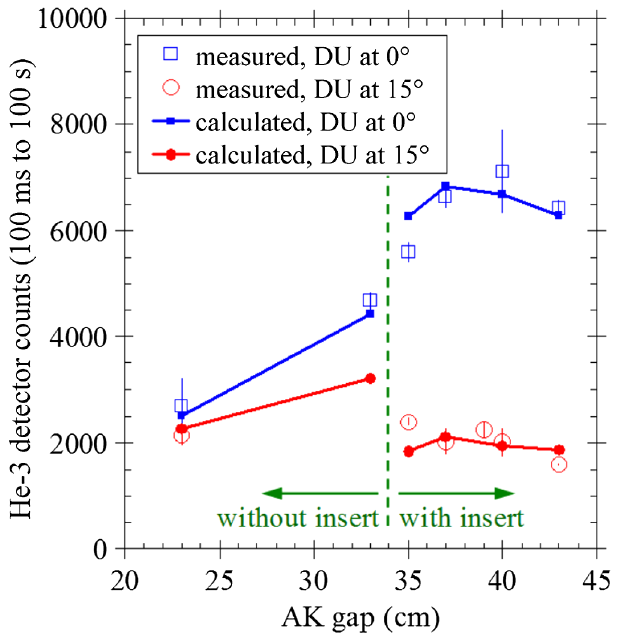
FIG. 13. Measured He-3 counts between 100 ms and 100 s for a detector 1 m from the DU plate on axis (squares) and 15° off axis (circles) as a function of AK gap. Error bars reflect shot-to-shot variations for each geometry. The curves are from LSP/ITS predictions of Fig. 12(b) and a conversion to He-3 counts described in the